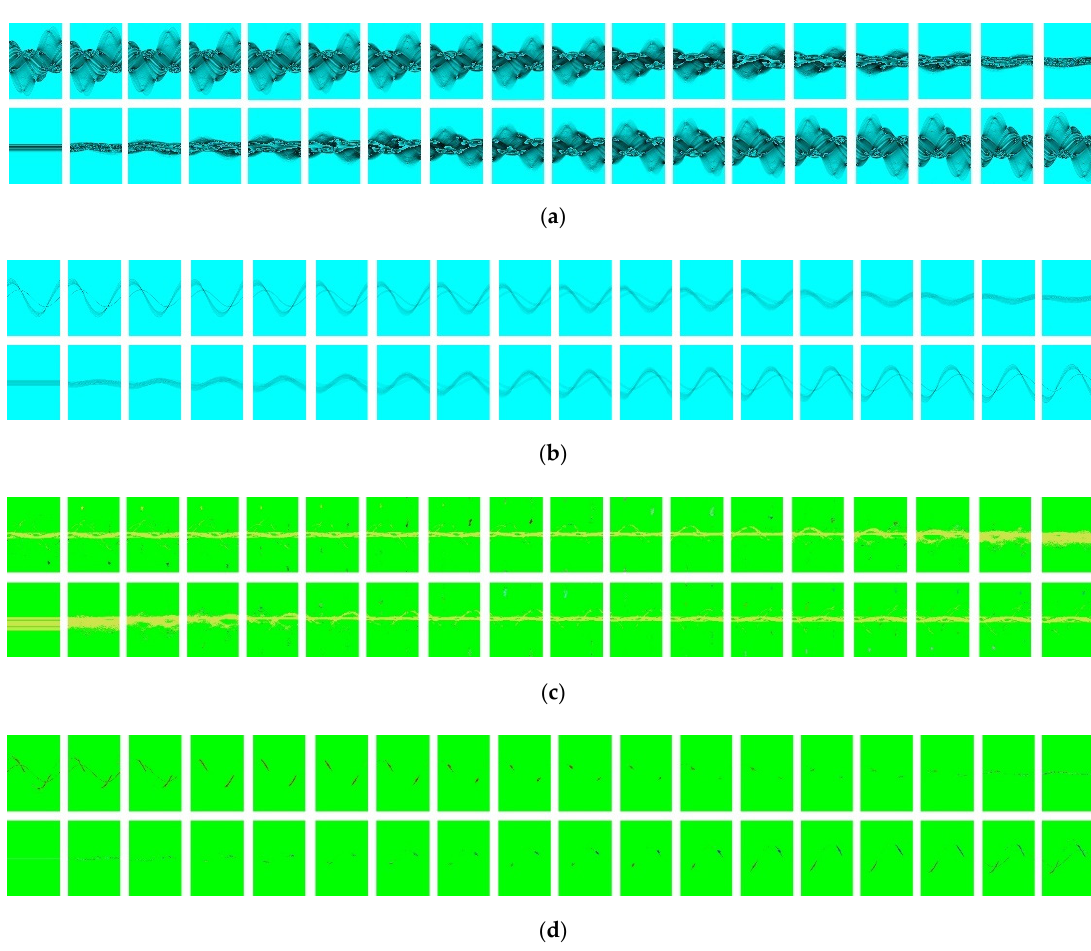
Figure 7. Display order of a 3D Hough space buffer.